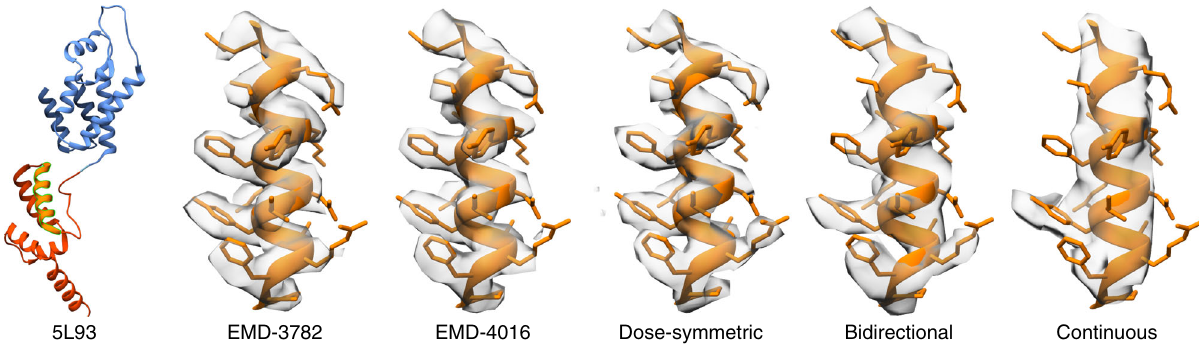
Fig. 3 Structural details of averages obtained using different acquisition schemes. An individual helix of HIV-1 CA-SP1 as structurally determined previously is shown in comparison to the dose-symmetric, bidirectional and continuous scheme used in this study. PDB 5L93 indicating the position of the helix is increases almost linearly, the other schemes plateau at ~8000 particles.